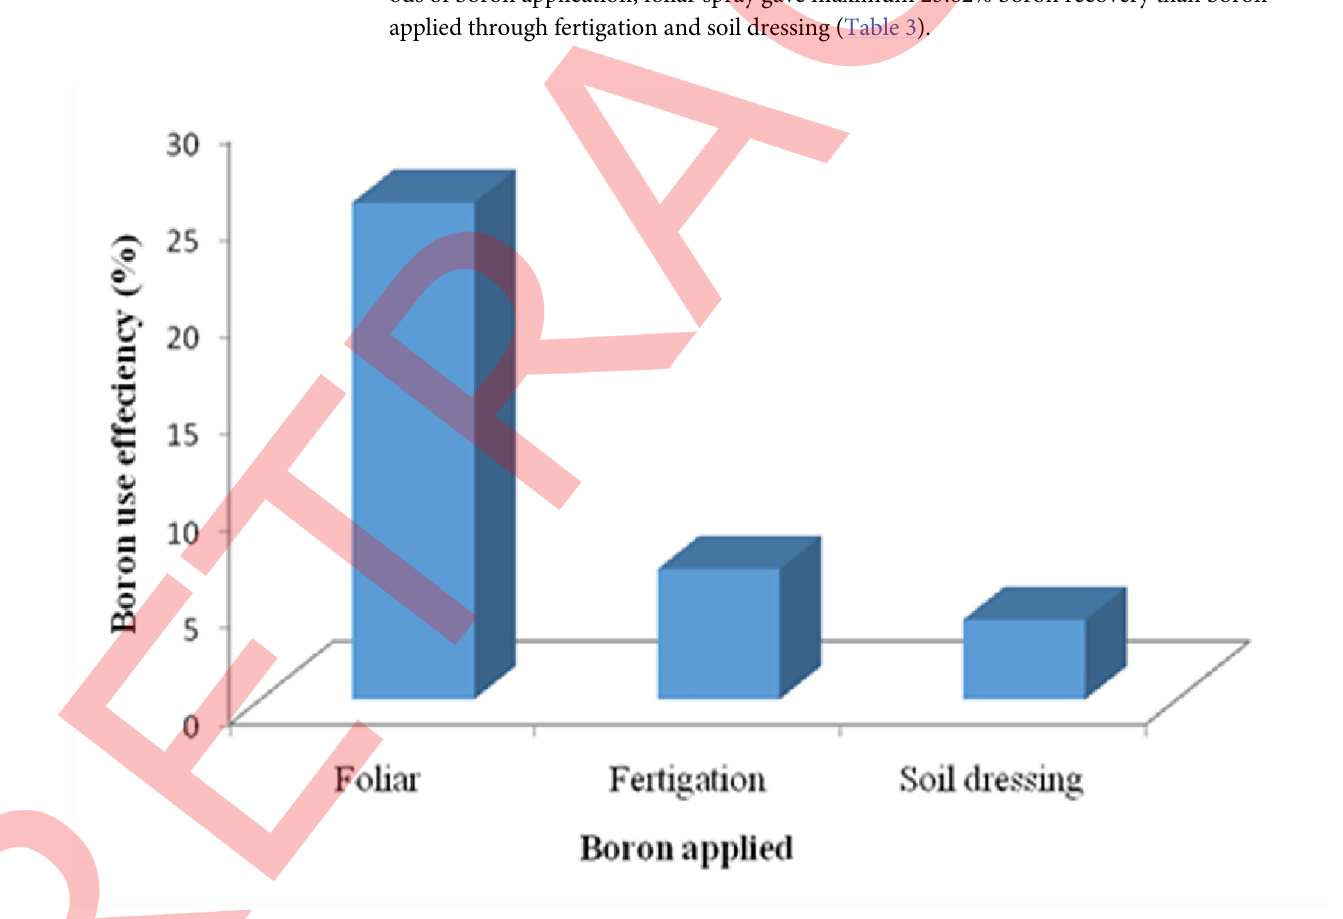
Fig 1. Comparative effect of boron application methods on the boron use efficiency of potato